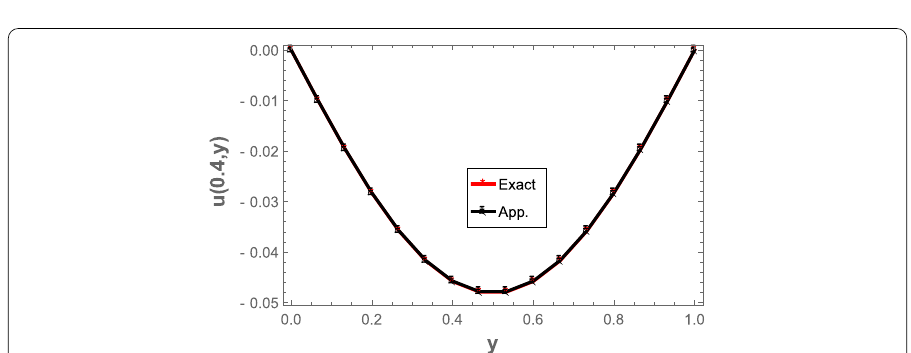
Figure 9 The numerical results are compared to the exact results at x = 0.4